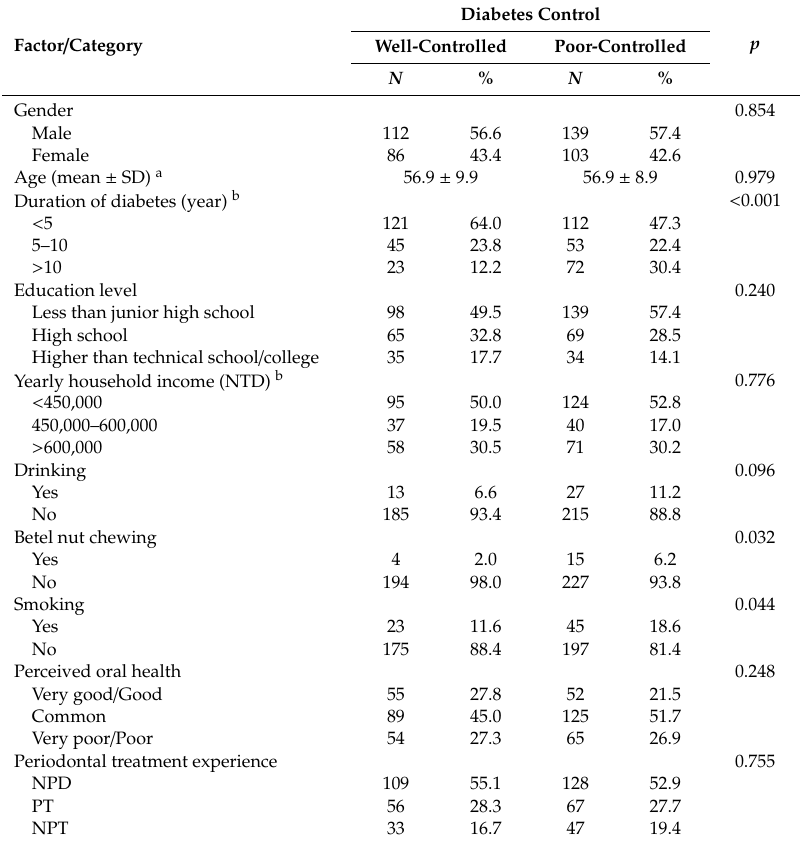
Table 1. Distribution of sociodemographic characteristics stratified by glycemic control status in type 2 diabetes mellitus (T2DM)